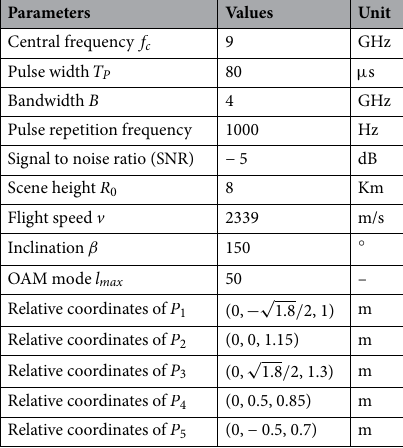
Table 1. Key parameters in the simulation.